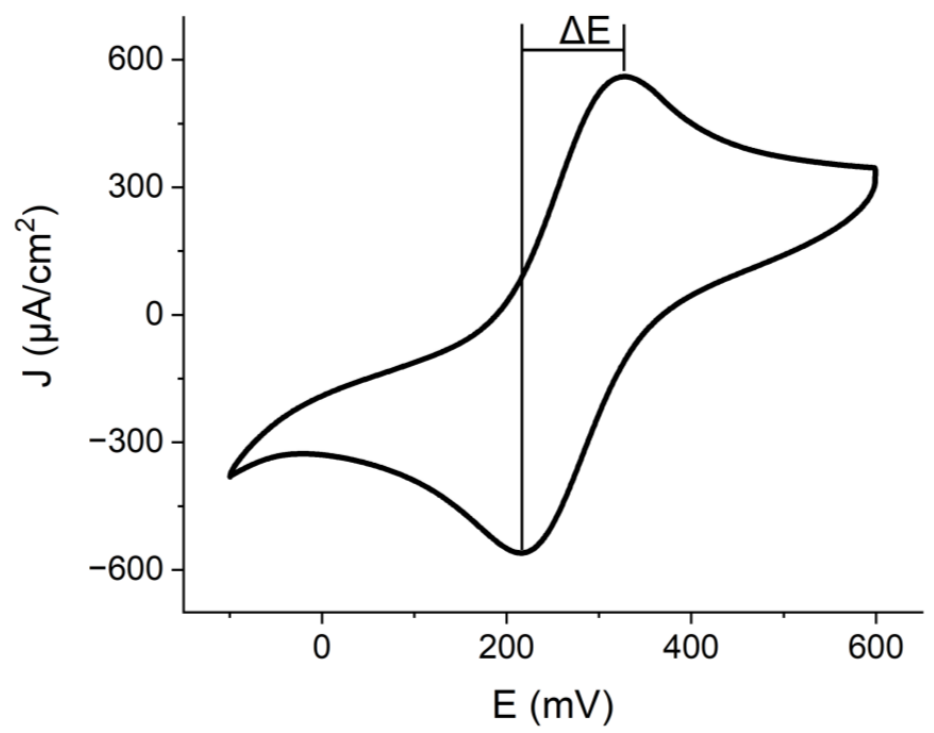
Figure 2. Gold electrode assessment using cyclic voltammetry in PBS (pH 7.4) with 2 mM of [Fe(CN) 6 ] 3 − and 2 mM of [Fe(CN) 6 ] 4 − as a redox probe.